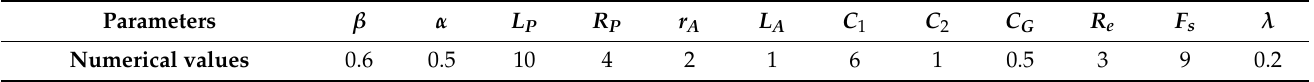
Table 6. Parameter assignment for